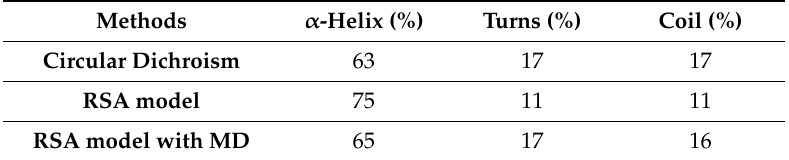
Table 3. Secondary structures percentage of RSA obtained through circular dichroism (CD) of the RSA model obtained through comparative modeling and of the RSA model after 50 ns molecular dynamics (MD).